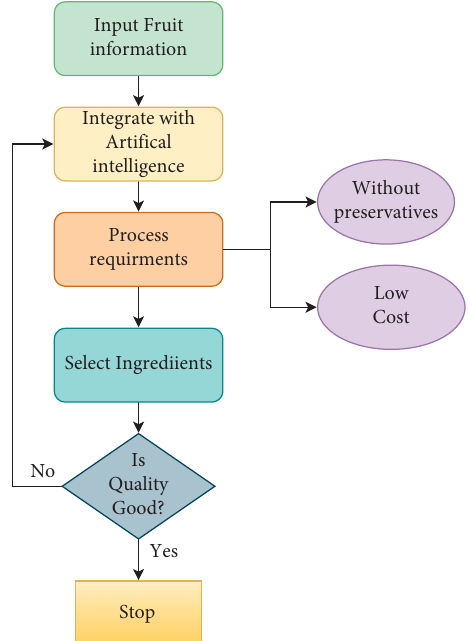
Figure 1: Use of AI for loquat compote